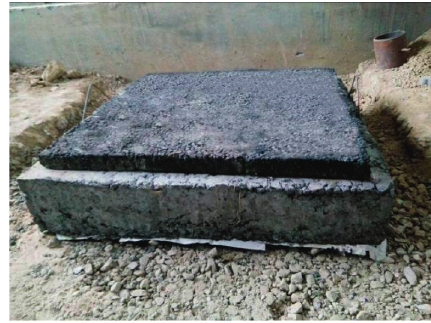
Figure 10: The movable pavement of the physical model.